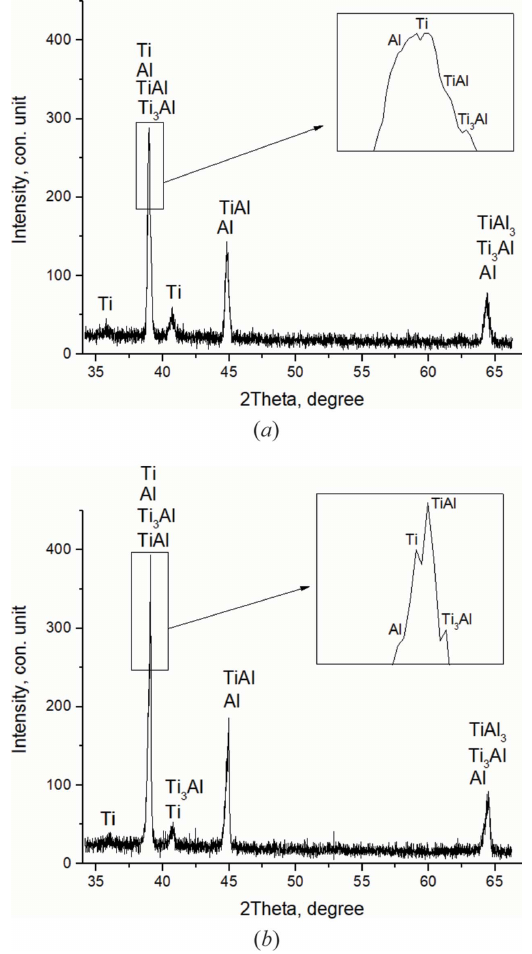
Figure 7 Diffractograms of the 16th ( T = 620.7 (cid:3) C) ( a ) and the 20th ( T = 656.5 (cid:3) C) ( b )